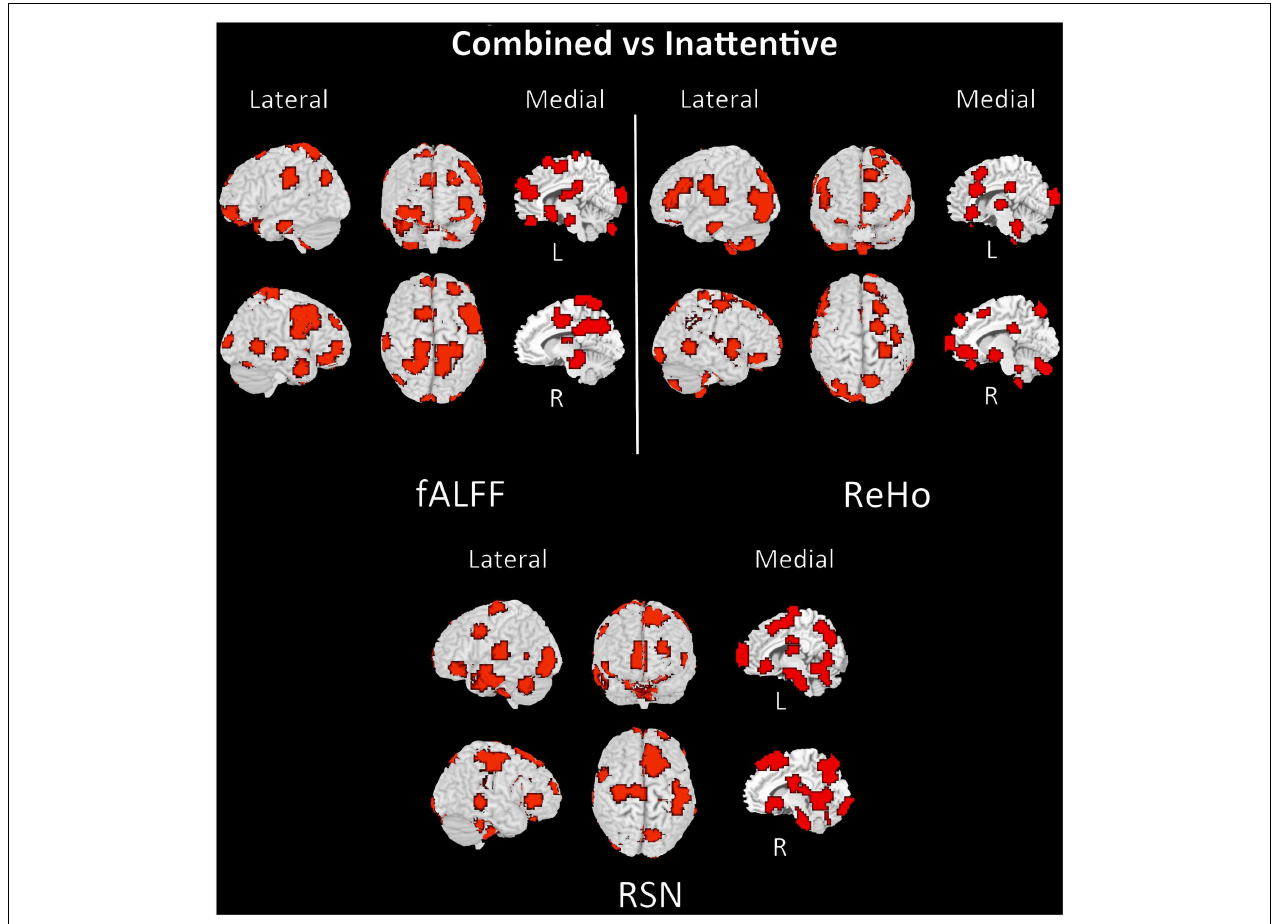
FIGURE 5 | Brain mapping of 5% regions containing most discriminative information performance in combined vs. inattentiveADHD patients classification when using fALFF + REHO + RSN4